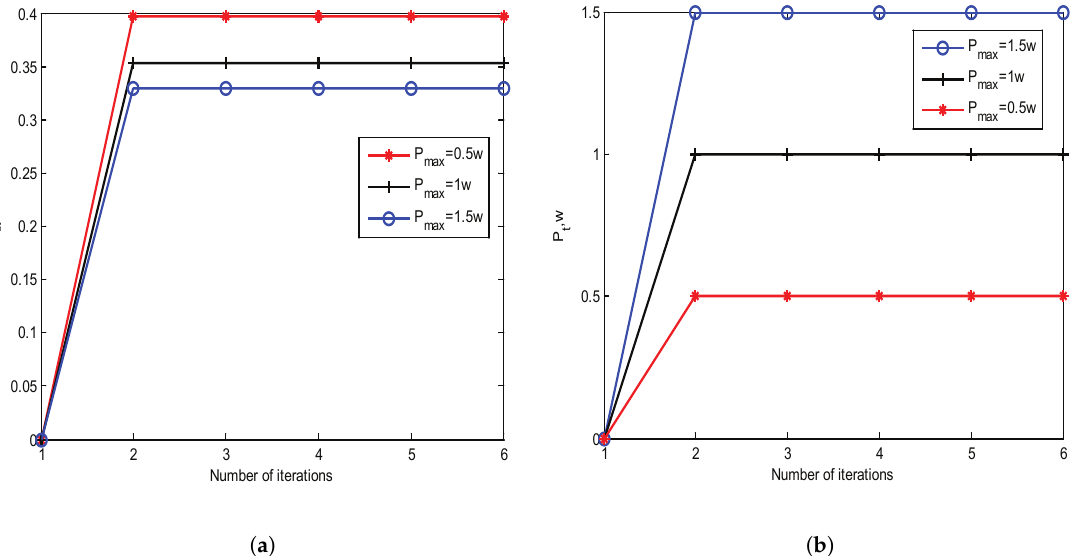
Figure 4. The convergence of Algorithm 2: ( a ) TS factor against iteration numbers; and ( b ) transmission power of the source against iteration numbers.